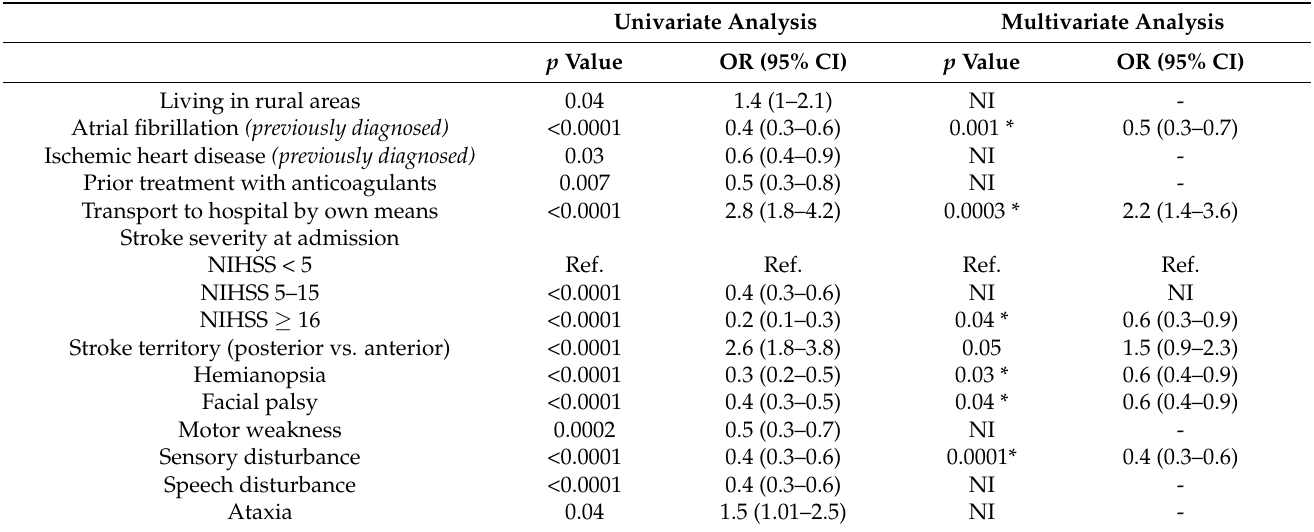
Table 2. Factors associated with hospital arrival after 4.5 h from stroke